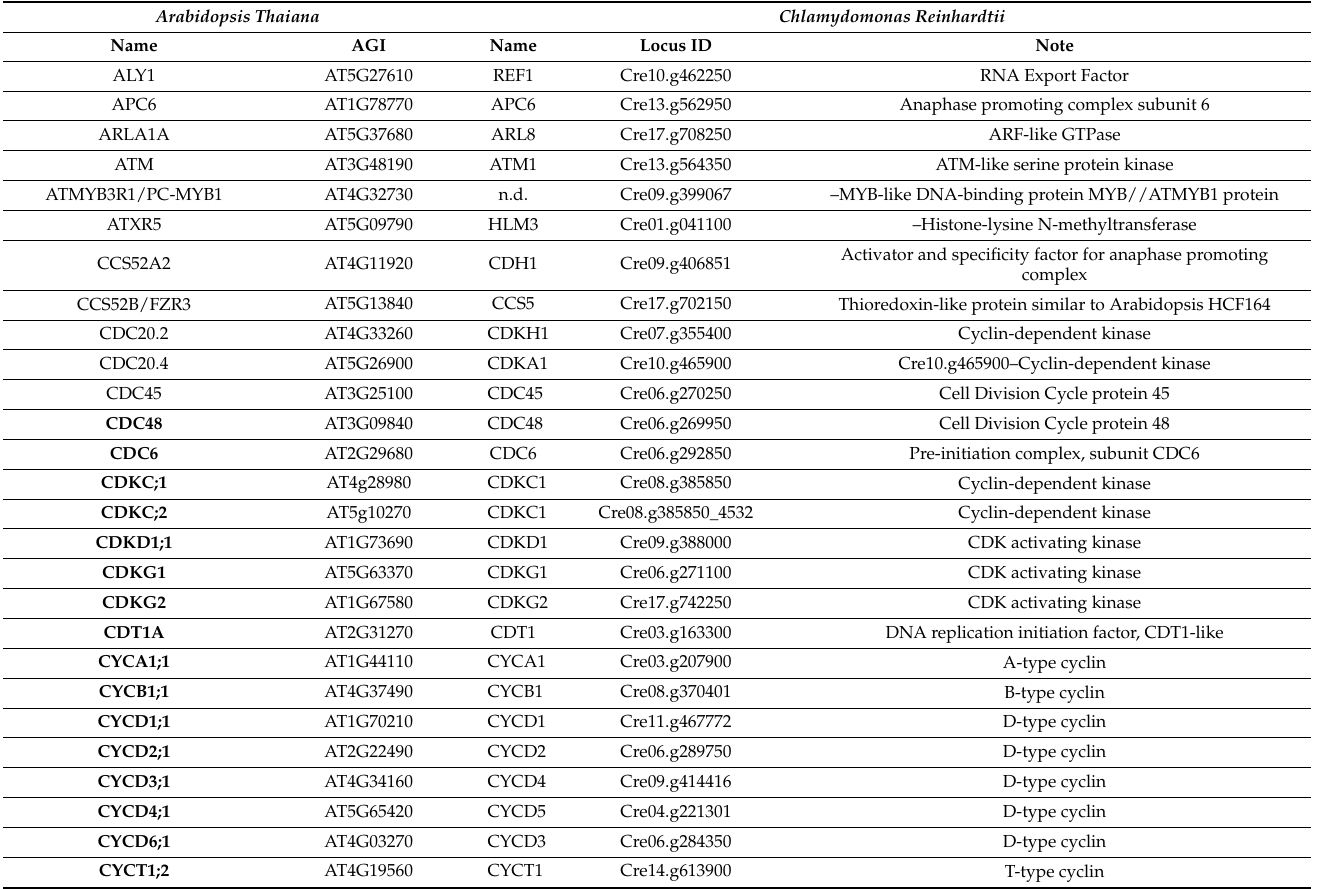
Selected cell cycle-related genes, found to be potentially redox regulated; after Foyer et al., [91] (column 1 and 2); calculated by NetSurfP) and their homologues identified in the Chlamydomonas reinhardtii genome (columns 3–5), according to JGI Phytozome13 Plant genomic resource analysis (at least 65% homology). Abbreviation in 3rd column: n.d.–not defined for Chlamydomonas